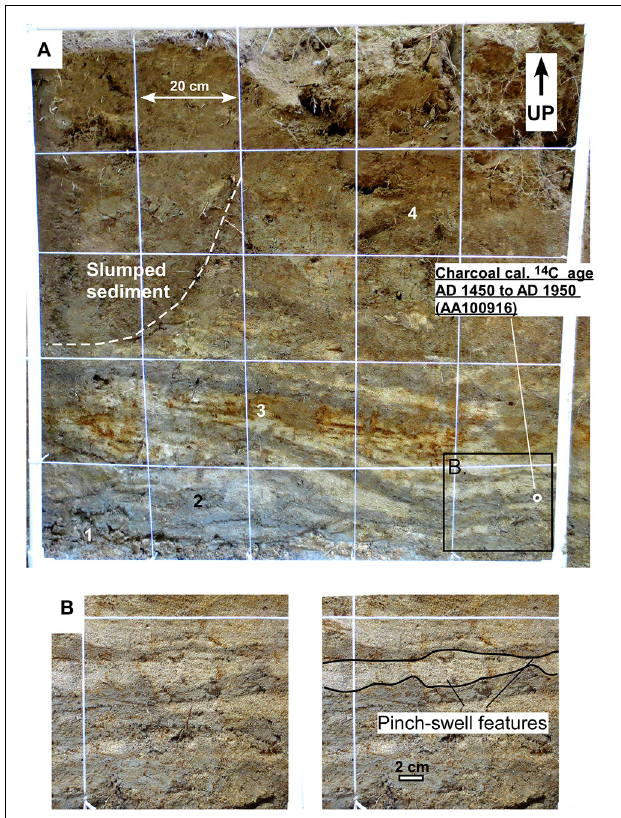
FIGURE 8 | Site C (Langford Creek; 33.66931 ◦ N, 91.88531 ◦ W)—Top is up. Location of (B) is shown on (A) . Photograph of possible small liquefaction features in Holocene sediment. (A) 1 × 1m grid on vertical excavation. Unit 1, Langford Creek channel, medium-bedded gravel; Unit 2, Langford Creek, point-bar, medium interbeds of fine sand and clay; Unit 3, Langford Creek, point-bar, medium-bedded fine sands with minor clay lenses; Unit 4, Overbank, massive loam (aggraded A soil horizon). We interpret the detrital charcoal 14 C age from Sample AA100916 to pre-date possible liquefaction, and thus it places a maximum age of AD 1450on the inferred triggering paleo-earthquake. (B) Photograph details showing minor pinch-swell features. Alternatively, this deformation may be due to sediment loading.